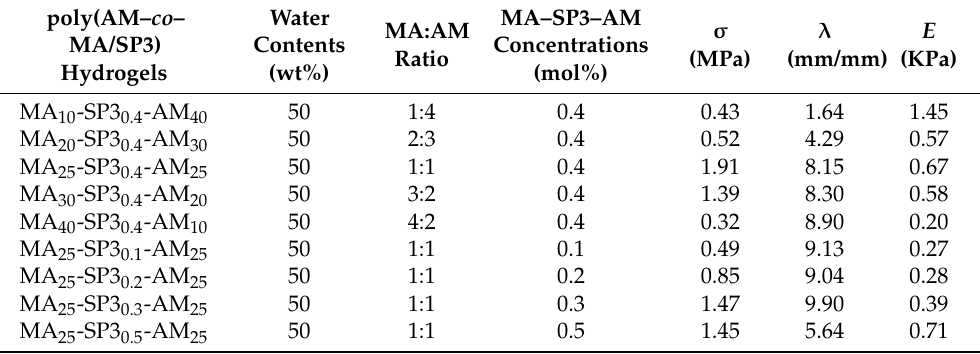
Figure 1. Scheme for the preparation of poly(AM– co –MA/DMSP3) hydrogels and the mechanism of their mechanochromic characteristic. Table 1. Synthetic formula and mechanical properties of the poly(AM– co –MA/DMSP3) hydrogels prepared under different